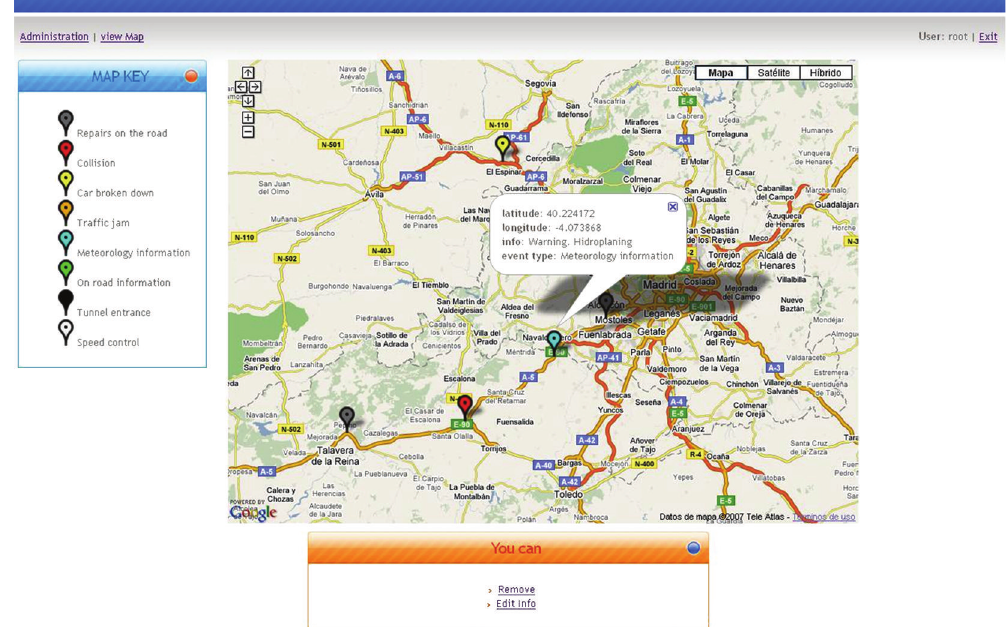
Figure 6: Road incidences monitoring at the ITOS Web